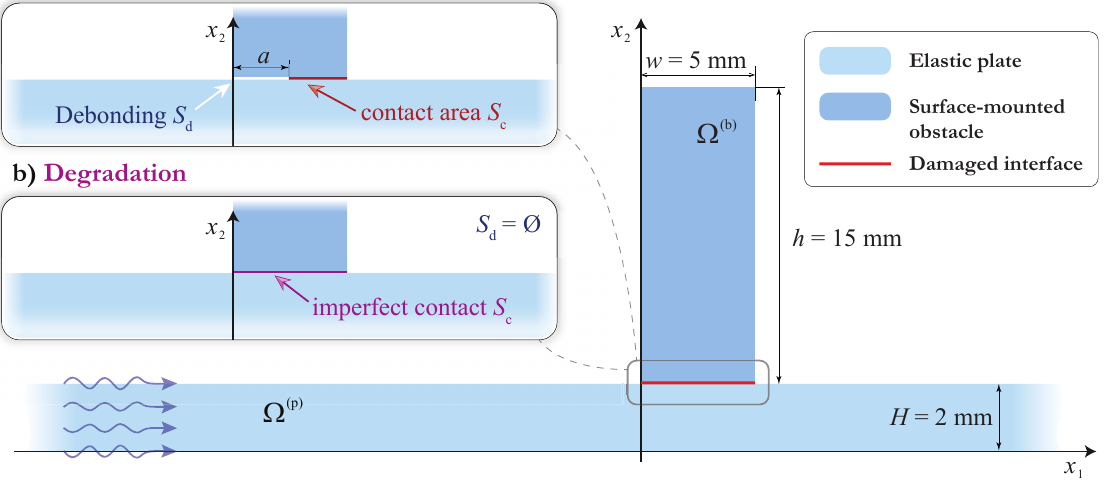
Figure 9. The geometry for the mathematical